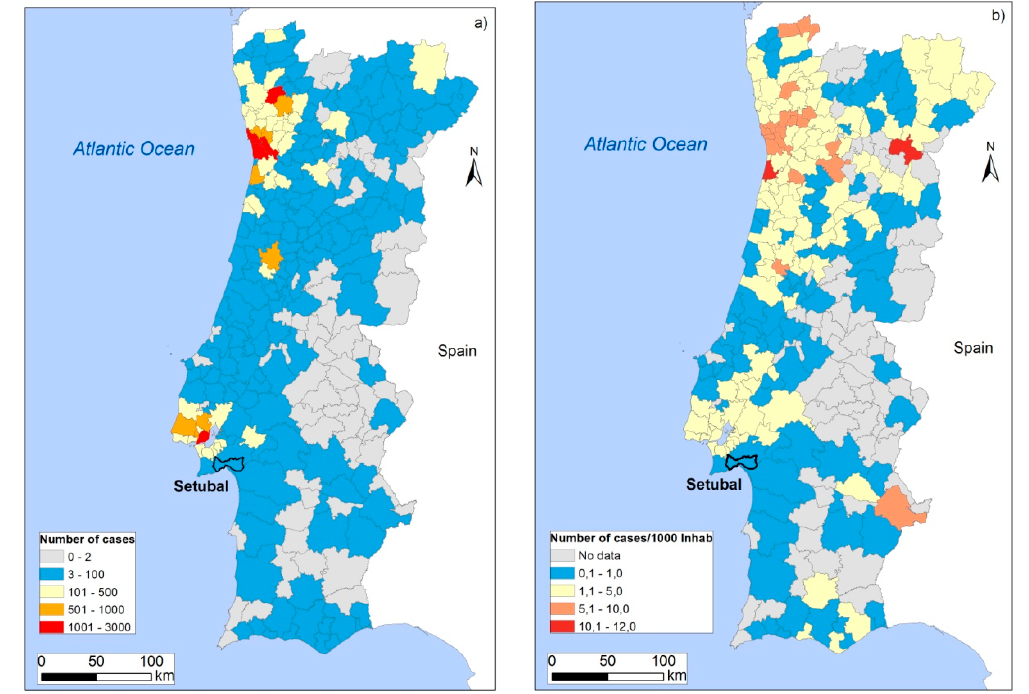
Figure 8. Geographic distribution of infected cases due to COVID-19 in Portugal mainland on May 19, 2020: ( a ) Number of infected cases on each municipality; ( b ) Number of infected cases per 1000 inhabitants on each municipality. (Data compiled from [41,42,45]. When less than three cases were reported, data are not shown).